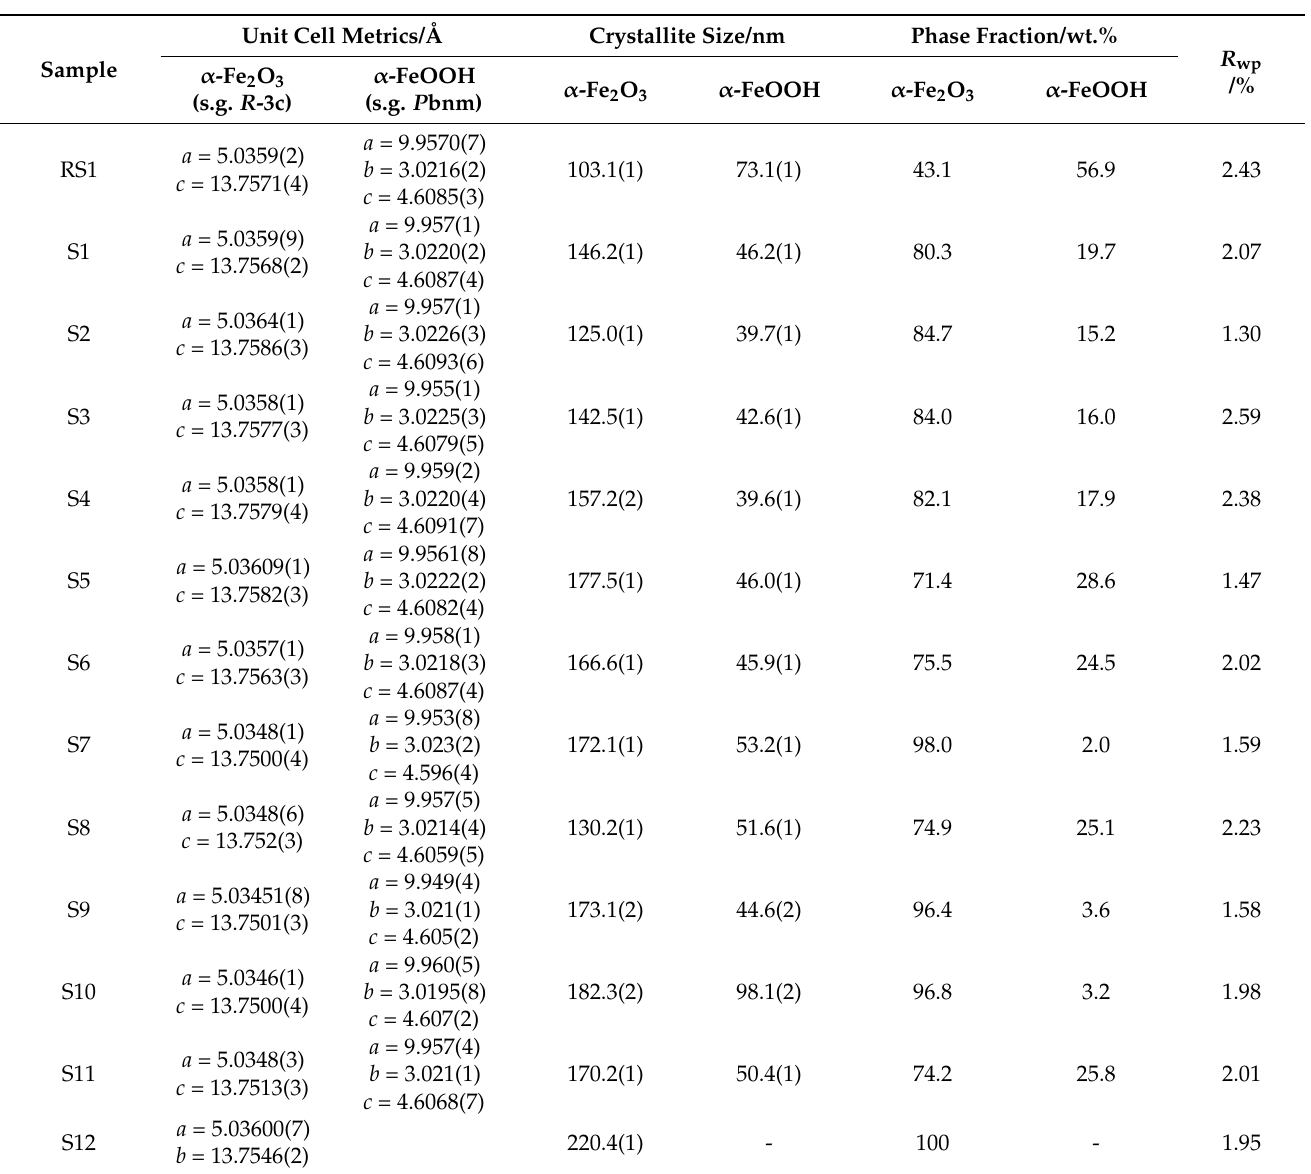
Table 3. The notation of samples prepared at 200 ◦ C for 20 min, results of phase analysis, and